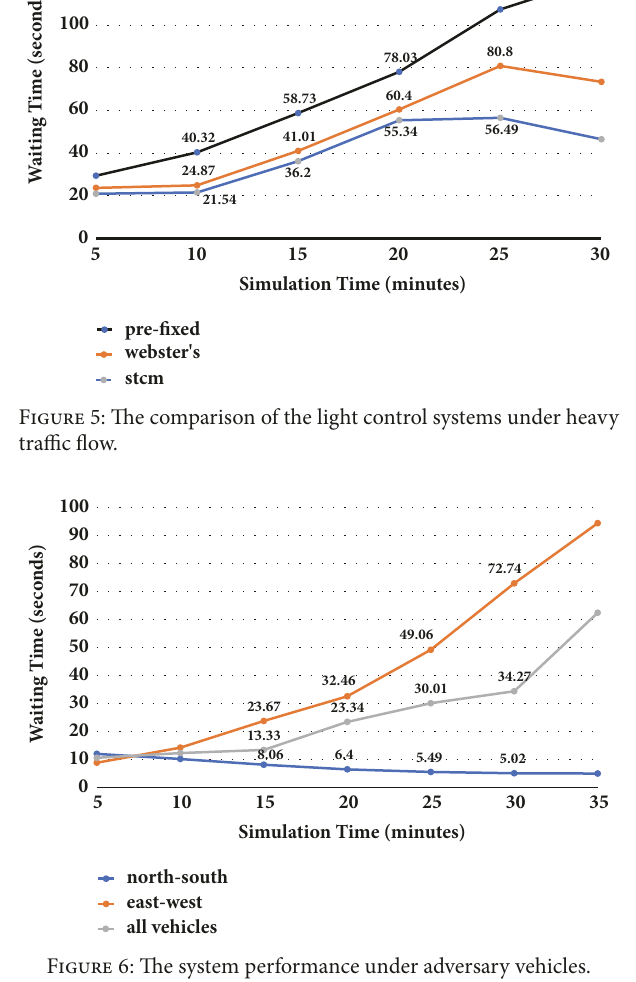
of the truthful vehicles is decreased over time during the simulation. The waiting times for all vehicles between the 70% and 90% penetration levels are similar to those for the 100% levels. There is, however, an increase in average waiting times under the penetration levels of 50% and lower.